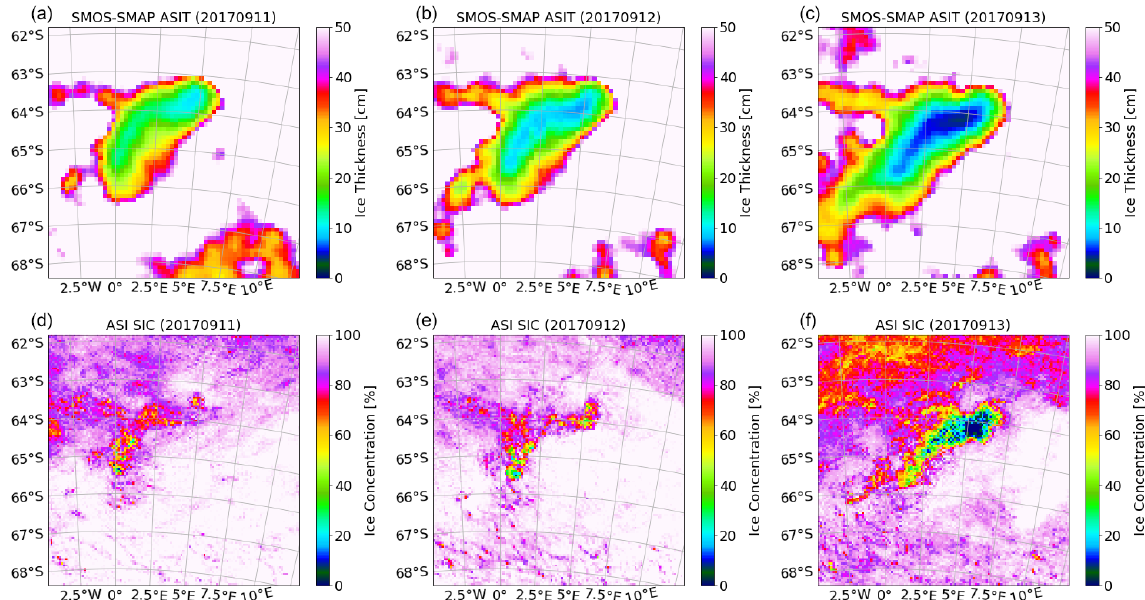
Figure 3. SMOS–SMAP ASIT (a–c) and ASI SIC (d–f) retrieval of the days leading up to the 2017 Weddell Sea polynya: 11–13 Septem- ber 2017.